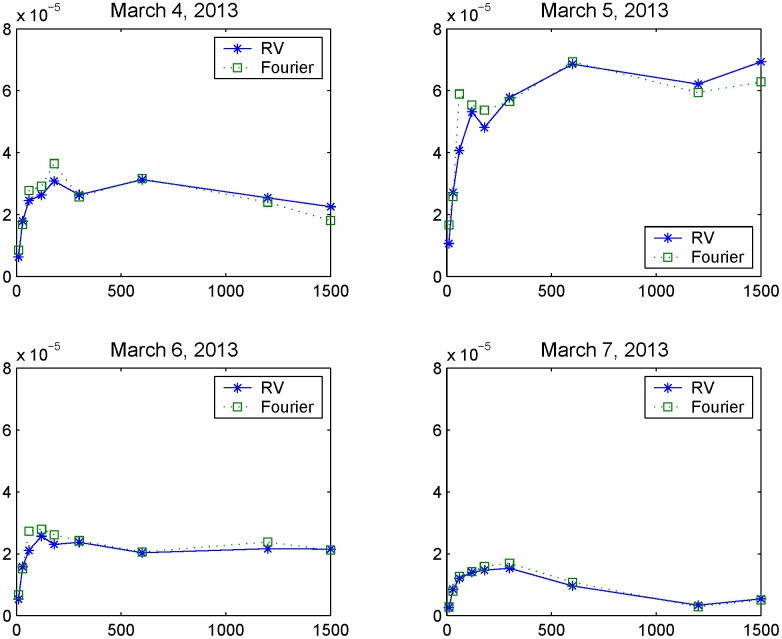
Volatility signature plots versus sampling frequency in seconds.The graphs show the signature plots of illiquid market data on March 4-7, 2013.